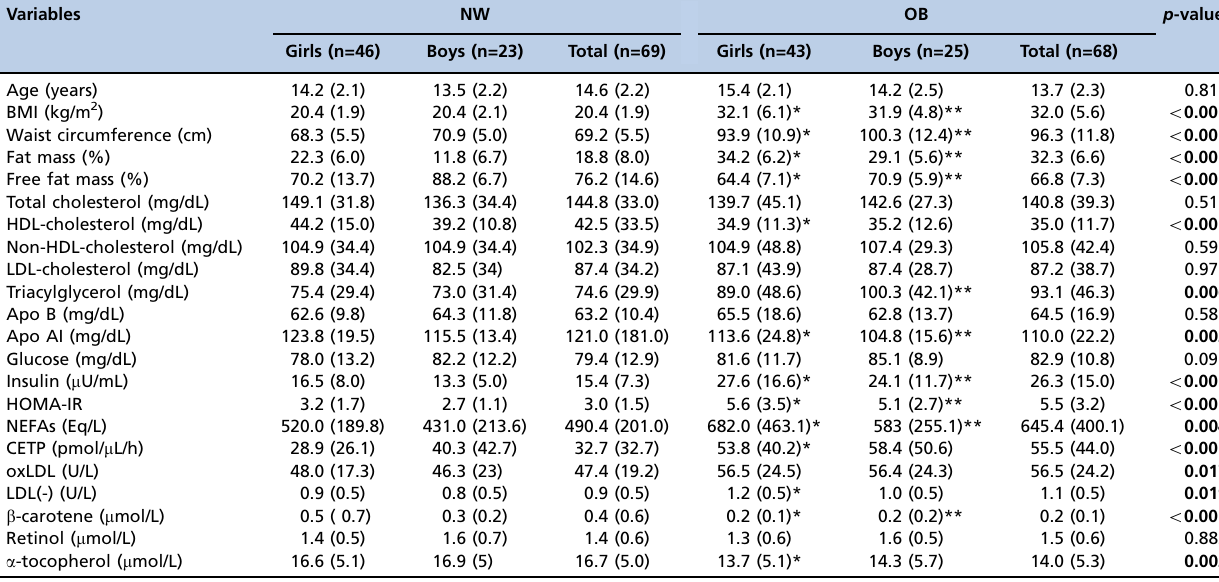
Table 1 - Anthropometric and biochemical parameters in normal weight (NW) and obese (OB) adolescents.